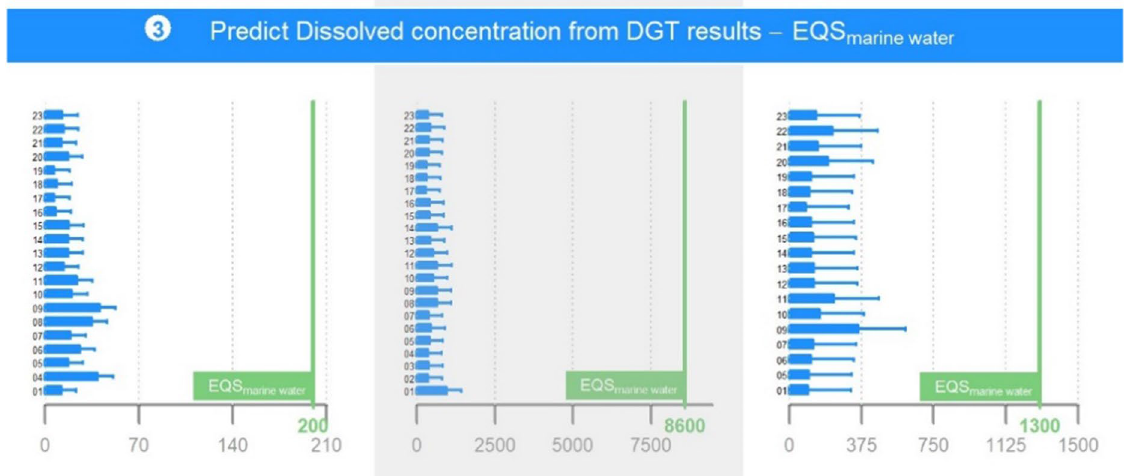
Fig. 5 Simulation of “chemical status” assessment per MONITOOL site for cadmium, nickel and lead: ❶ Annual mean dissolved concentration (in green) and indication of EQS marine water; ❷ Annual mean labile DGT concentration (ng · L − 1 ) (in blue) and indication of (A)‑EQS DGT nos. 1 and 2; ❸ Predict dissolved concentration from DGT results (Eq. 2) and indication of EQS marine